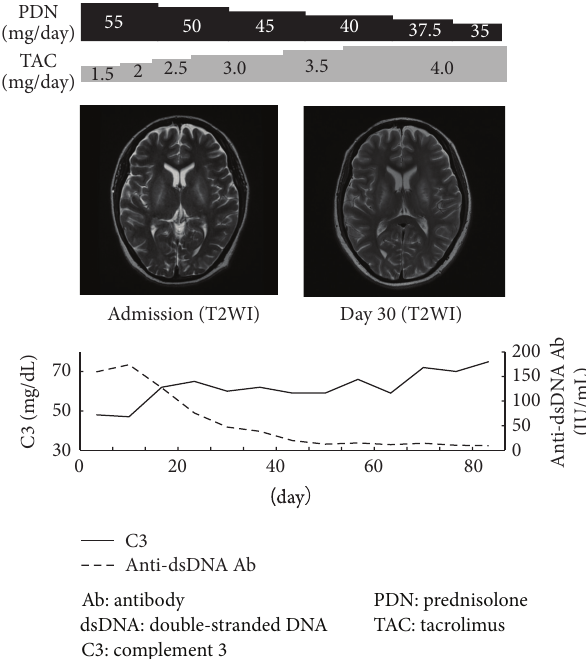
Figure 3: Clinical course: hersymptoms such aserythema, alopecia, and arthralgia rapidly improved. Laboratory data showed increasing level of C3 and decreasing level of anti-double-stranded DNA anti- body. Neuropsychiatric symptoms such as obnubilation, decreased muscle strength, and cerebellar ataxia generally improved. But her head MRI findings did not change